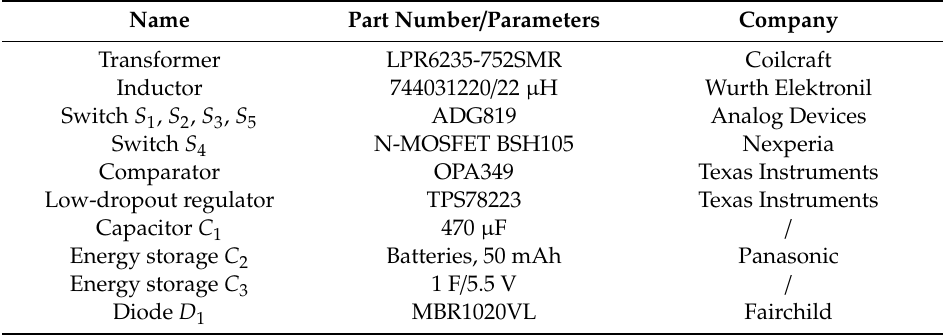
Table 2. The main electronic components used in the